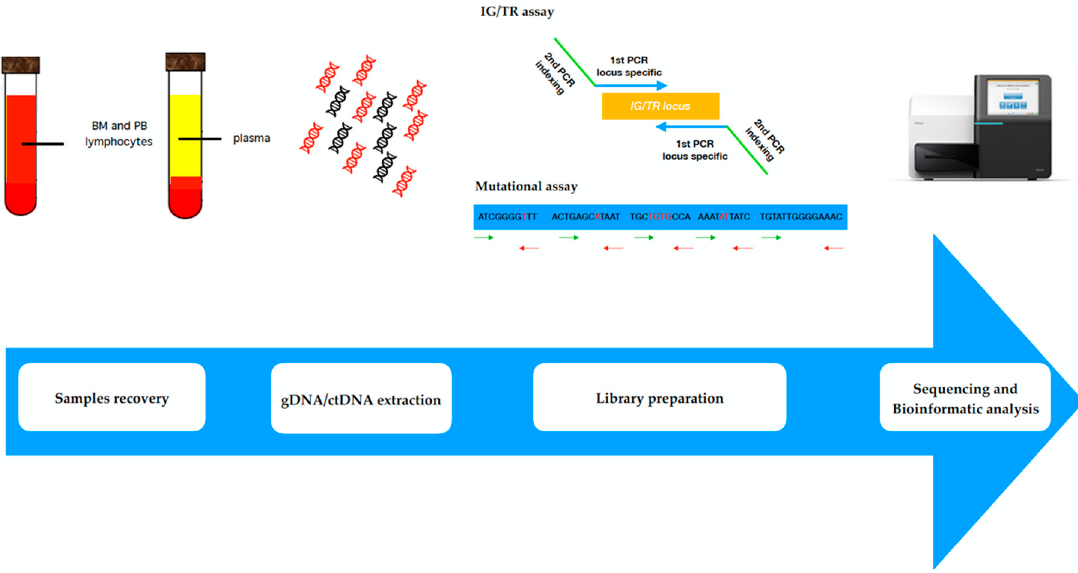
Figure 2. Next generation sequencing workflow. BM: bone marrow; PB: peripheral blood; ctDNA: circulating tumor DNA; IG/TR: immunoglobulin/T cell receptor.